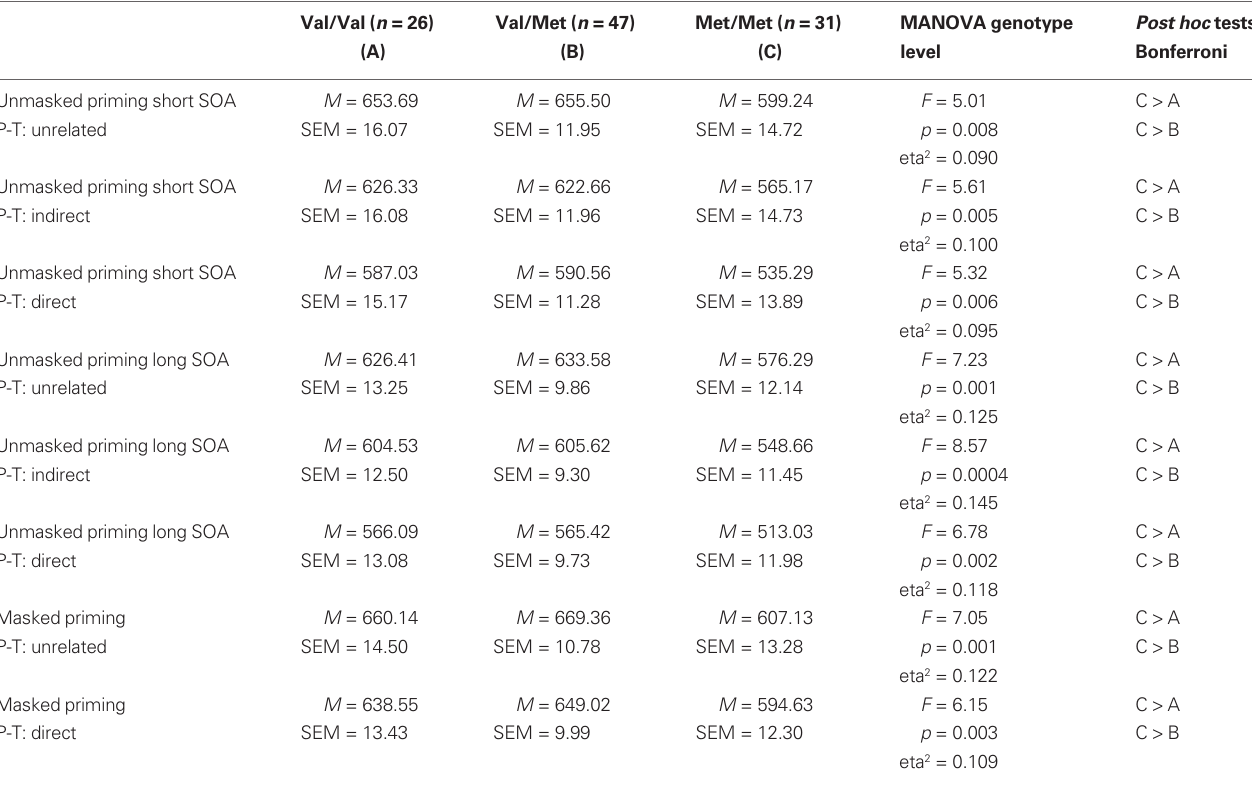
Table 2 | Association between lexical decision latencies in the semantic priming tasks and the COMT Val158Met